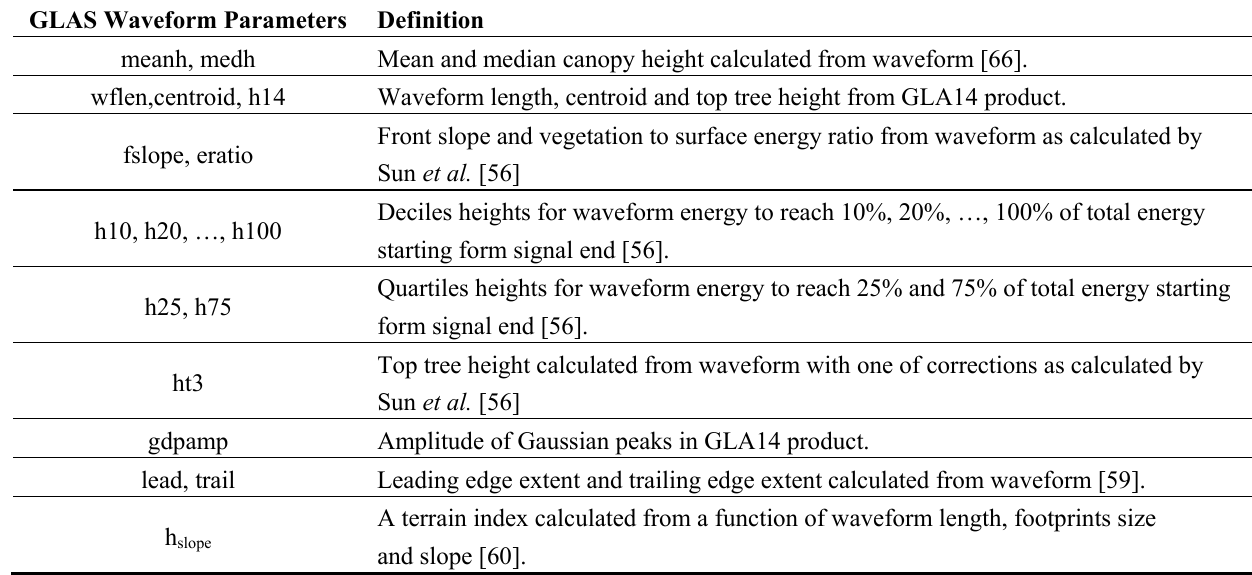
Table 2. Definition of GLAS (the Geoscience Laser Altimeter System) waveform